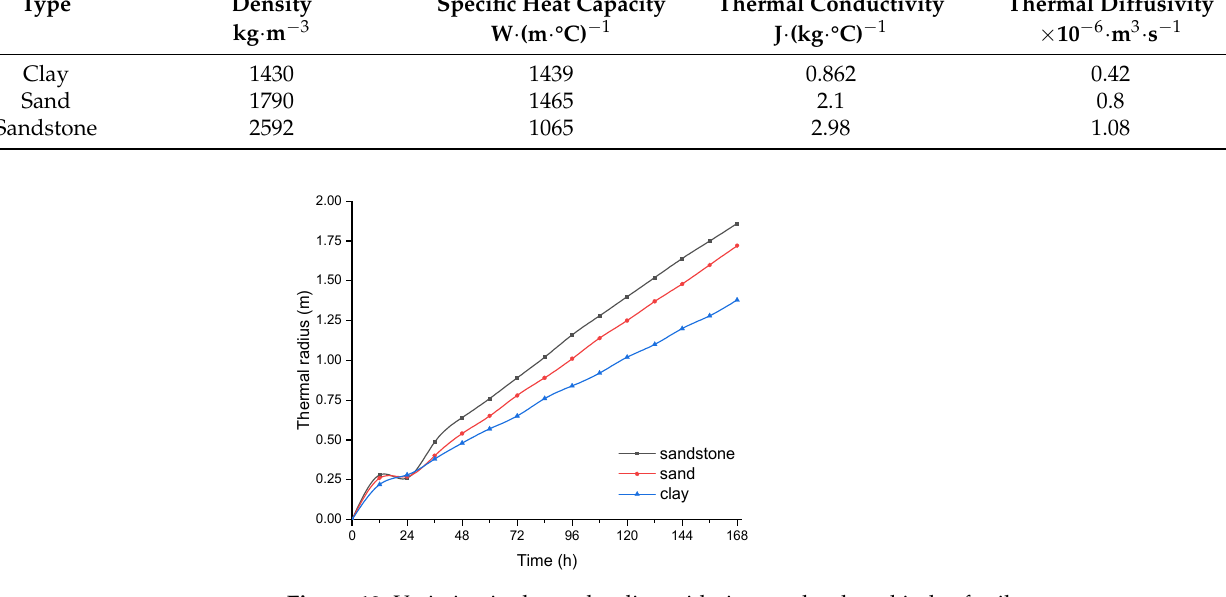
Figure 9. The distribution of soil excess temperature at the end of the operation and recovery period (at 12 h and 24 h) on the first day during the discharging process under different precooling times. ( a ) Operation period end; ( b ) Recovery period end.